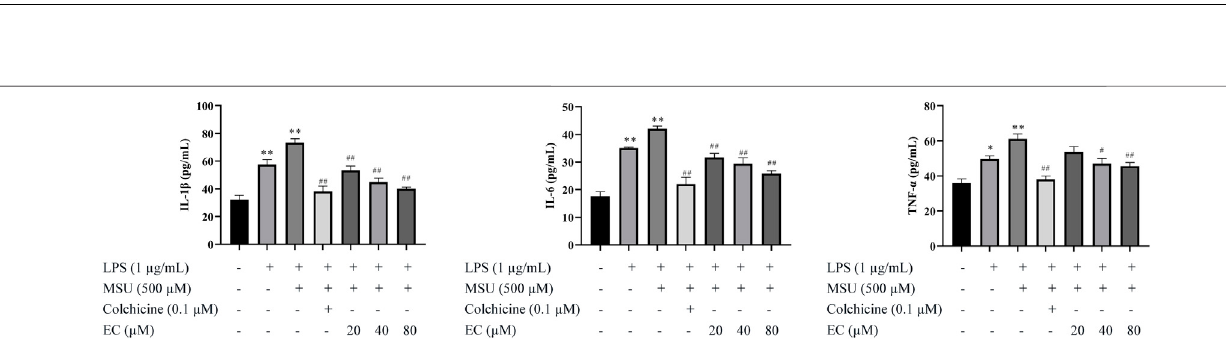
FIGURE1| EffectsofEConTHP-1cellviability. (A) EffectofECaloneonTHP-1cellviability.Afterinductionwith50 ng/mlofPMAfor48 h,THP-1cellsweretreated withdifferentconcentrationsofEC(2.5 – 640 μ M)for24 h. (B) EffectofEConTHP-1cellviabilitystimulatedbyLPSandMSU.AfterPMA(50 ng/ml)inductionfor48 hand LPS pre-stimulation for 24 h, THP-1 cells were pretreated with different concentrations of EC (2.5 – 160 μ M) for 0.5 h followed by MSU (500 μ M) stimulation for 23.5 h. Cell viability was determined using the CCK-8 assay kit. Data are represented as mean ± SEM of three independent experiments. ** p < 0.01 compared with the control group; # p < 0.05 or ## p < 0.01 compared with the LPS+MSU group.